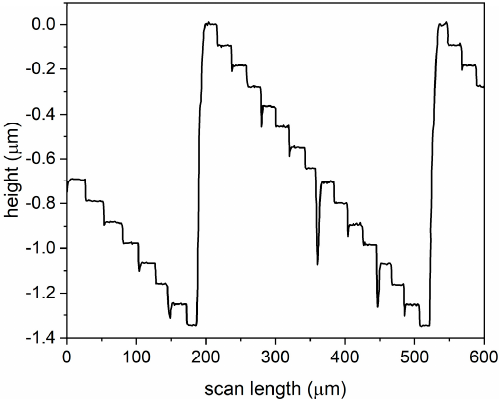
Figure 8. Cross-section profile of a zero-order axicon with 16 levels, measured with mechanical profilometer.